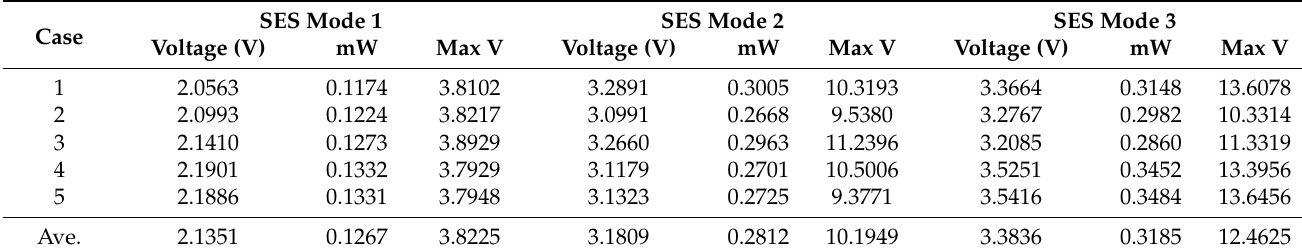
Figure 16. Schematic of SES and DES systems. Table 2. Experimental results of the voltage and power of the SES system.